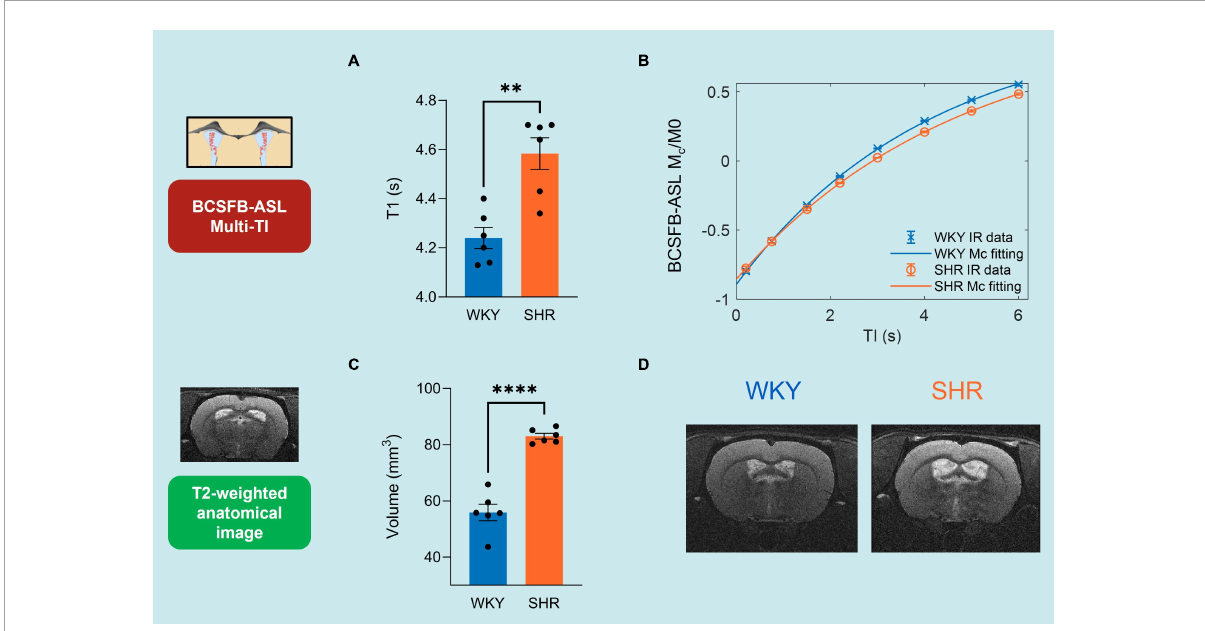
FIGURE3 CSF homeostasis: T1 CSF and lateral ventricular volume. (A) T1 CSF values from WKY and SHR subjects, extracted from BCSFB-ASL multi-TI data. Error bars: ± SEM ( n = 6 WKY, 6 SHR). (B) Example of multi-TI inversion recovery fitting ( n = 1 WKY, 1 SHR). Error bars: ± stdev (20 repetitions at each TI). (C) Lateral ventricular volume values from WKY and SHR subjects, from T2-weighted anatomical images. Error bars: ± SEM ( n = 6 WKY, 6 SHR). (D) Examples of T2-weighted anatomical images (equivalent slices) displaying ventriculomegaly ( n = 1 WKY, 1 SHR). Asterisks: 2-tailed t -test significance, * p < 0.05, ** p < 0.01, *** p < 0.001, and **** p <